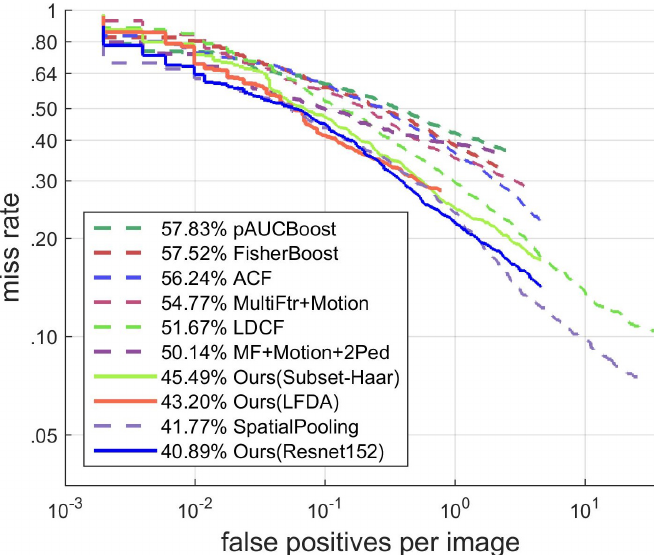
Figure 6. The performance comparison of different methods on the TUD-Brussel dataset.